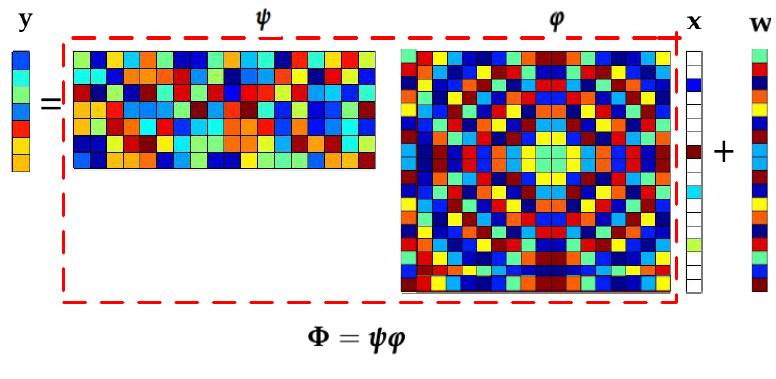
Figure 1. Frame of compressed sensing